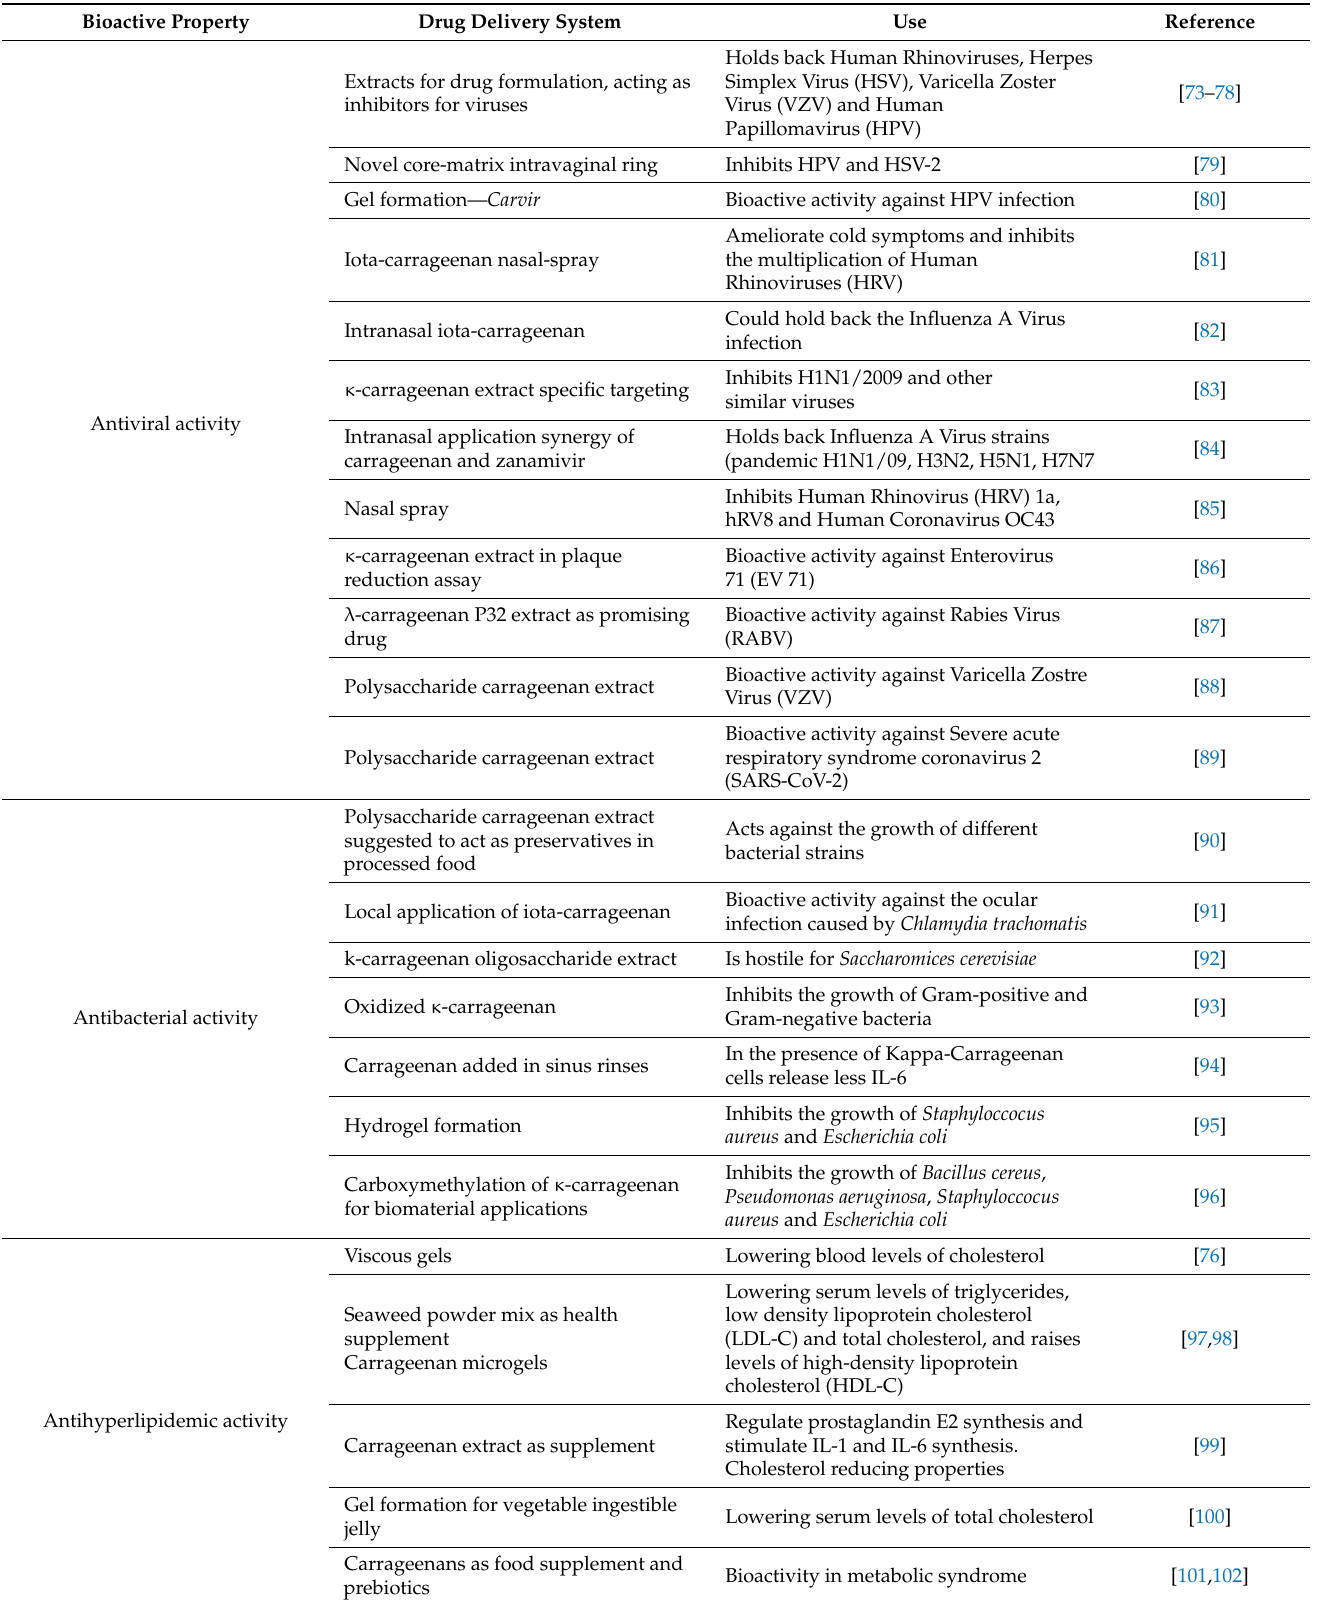
Table 3. Summary of carrageenans and the delivery systems used for various bioactive properties